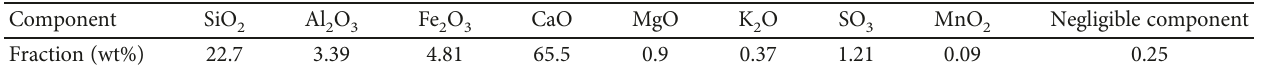
Figure 1: The processing steps of carbon fi bers. Table 1: Chemical composition of class G oil well cement.